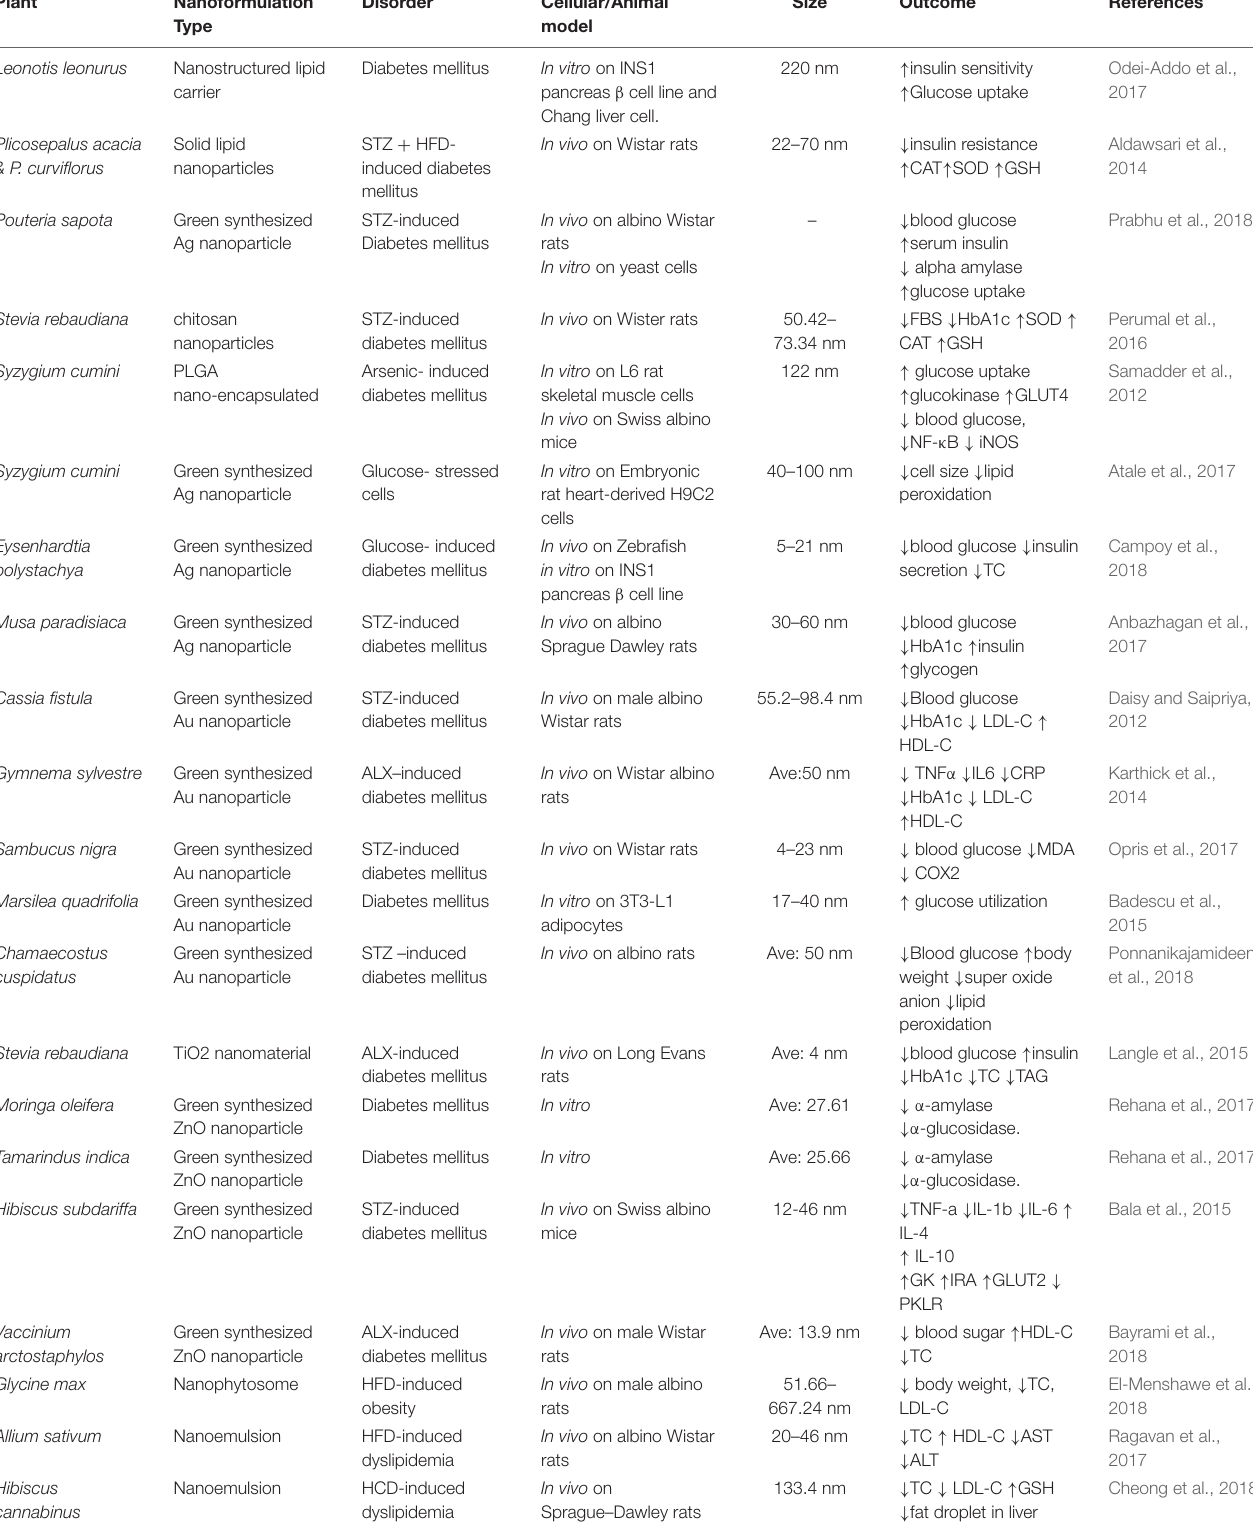
TABLE 1 | Herbal extracts based nanoscale drug delivery systems for treating metabolic